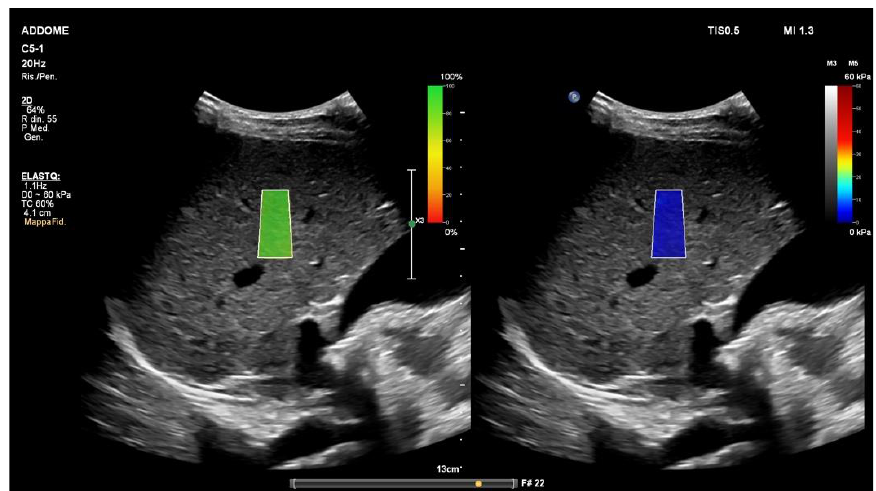
Figure 2. The 2D-shear wave elastography (ElastQ; Philips Medical System, Best, The Netherlands). The color-coded confidence map ( left ) reflects the quality of shear waves. The real-time 2D quanti- tative color map, namely elastogram ( right ), is superimposed on the B-mode. Even if ten stiffness values obtained from 10 independent images in the same location are generally required for liver ultrasound elastography, when a quality assessment parameter (confidence map) is used, five meas- urements may be appropriate. The ROI should be positioned at least 15 – 20 mm below the liver capsule [23].